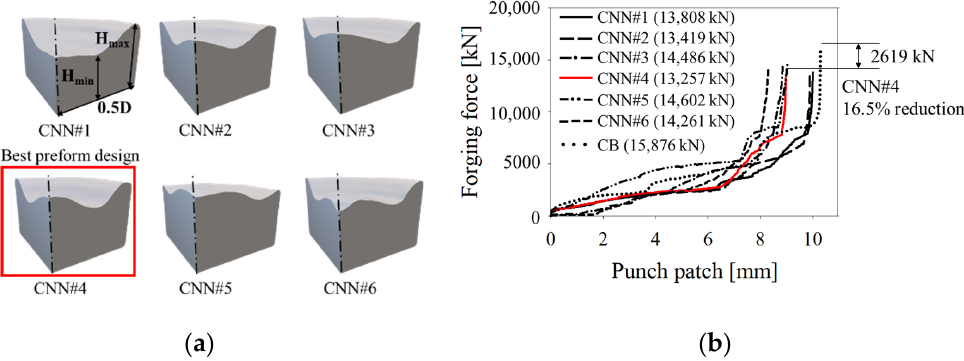
Figure 10. ( a ) Preform geometries and ( b ) forging force–punch patch curves computed for each of the CNN sub-models (including the cylindrical billet) for the forgings of Figure 8b. Table 2. Height features of the derived preform shapes for the axisymmetric forging shapes. Forging Shape